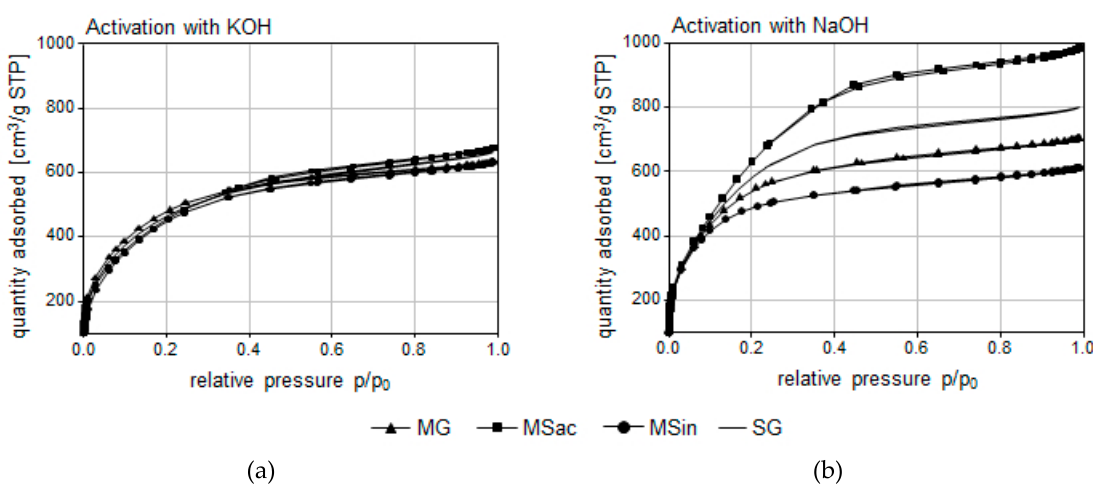
Figure 1. Isotherms of N 2 adsorption–desorption by ACs obtained from biomass of miscanthus species and switchgrass using KOH (a) or NaOH (b) as the activator.